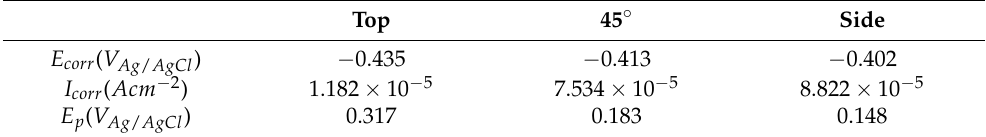
Table 5. The corrosion potential ( E corr ), corrosion current ( I corr ) and pitting potential ( E p ) of each